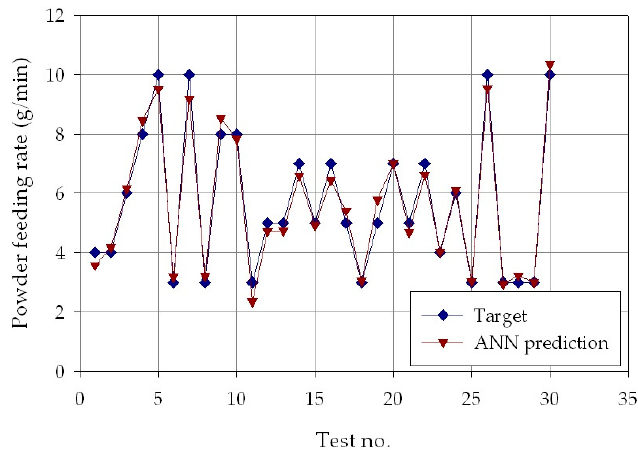
Figure 8. Experimental (blue marks) and ANN estimated (orange marks) powder feeding rate, ṁ , for each of the p = 30 experimental conditions.